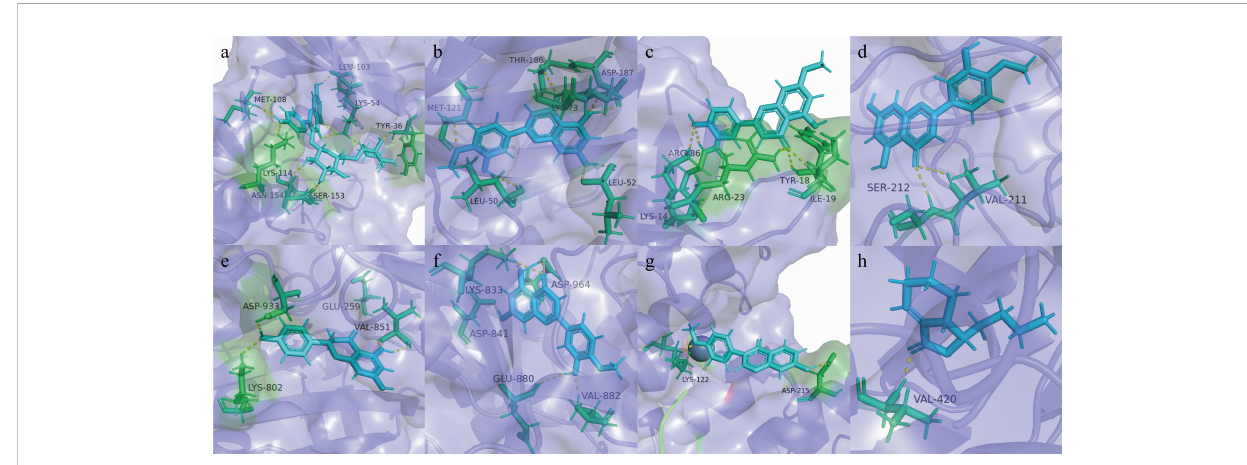
FIGURE 5 Molecular models of core targets binding to the related compound. (A) Mapk1 and Nicoti fl orin, (B) Mapk3 and Diosmetin, (C) Akt1 and Genkwanin, (D) Map2k1 and Diosmetin, (E) Pik3ca and Naringenin, (F) Pik3cg and Diosmetin, (G) Raf1 and Formononetin, and (H) Prkca and